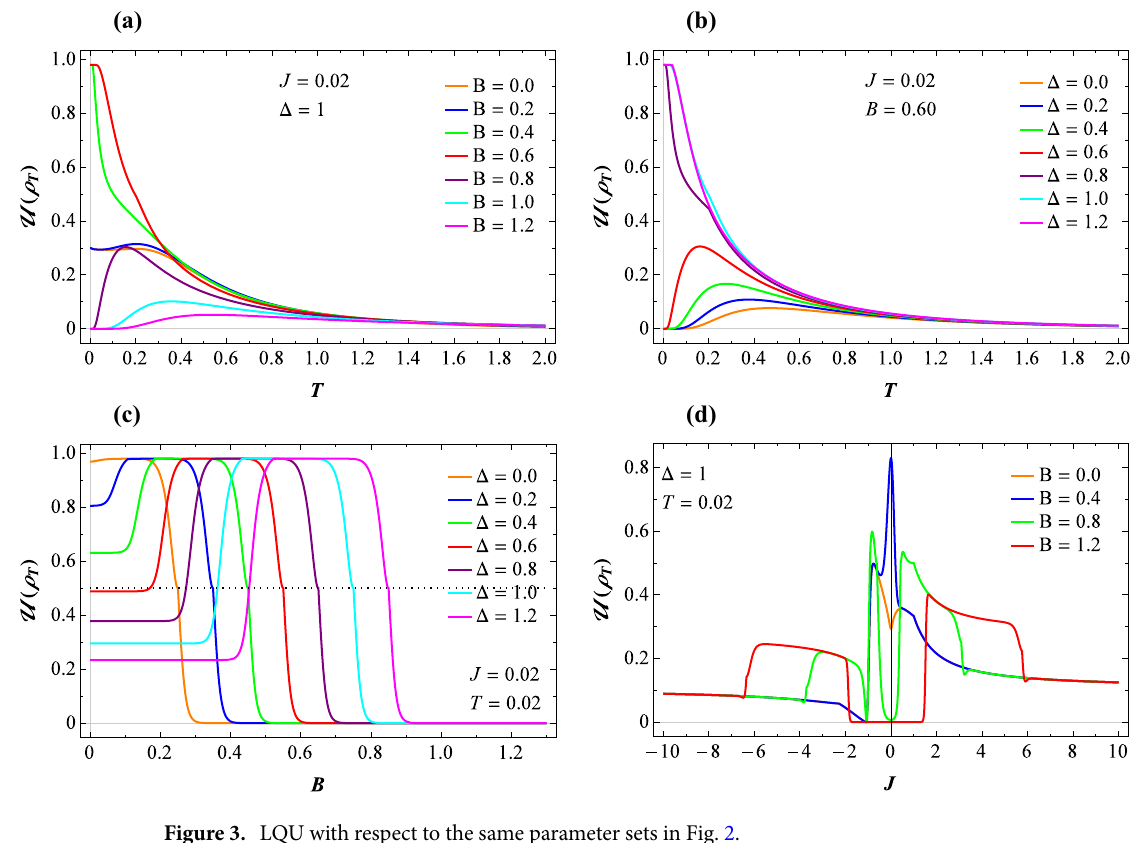
Figure 3. LQU with respect to the same parameter sets in Fig.